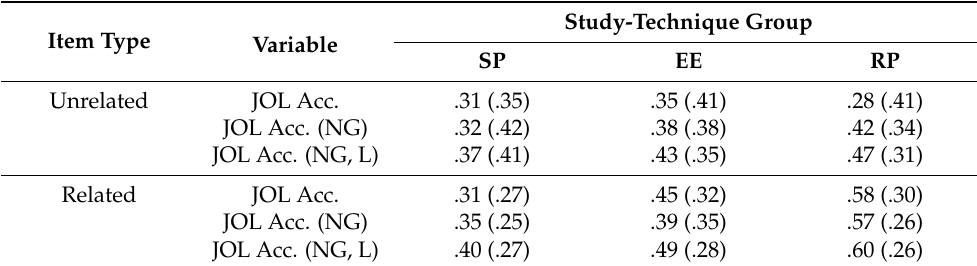
Table 3. JOL accuracy across levels of correct-guessing adjustment.